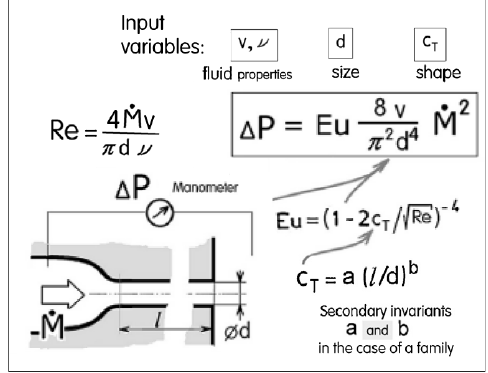
Fig. 9. Schematic representation of the steps in computation of pressure drop across a nozzle from known c T (or known secondary invariants, Fig. 7). It is assumed that Reynolds num- ber of the nozzle exit flow is Re > 2 000 (otherwise, in the creeping flow regime, it would be necessary to apply higher characterisation approach [12]